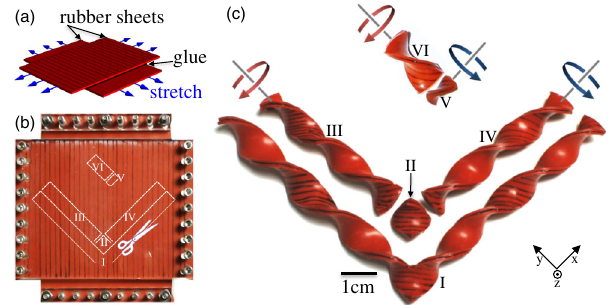
FIG. 1. Orientation-dependent manifestation of handedness in a reflection symmetric continuum. Two identical rubber sheets are uniaxially stretched and glued together to form a rubber bilayer, as done in Ref. [27]. Narrow strips cut from the bilayer curve out of plane to accommodate the difference in rest length between the layers and form helical structures. The square boundaries in II of panel (b) give rise to a cutout [II of panel (c)], which is symmetric under reflections. This is a manifestation of the symmetry of the bilayer’s intrinsic structure. symmetry, e.g., III and IVof panel (b), strips with a well-defined handedness observed depends solely on the orientation of the strip’s long axis; strips aligned with one diagonal generate right- handed helicoids, whereas strips oriented in the perpendicular direction generate left-handed helicoids. Slicing a narrow piece from a left-handed strip such that its aspect ratio is inverted yields a narrower strip of opposite handedness, as seen in V of panel (c), which was cut from VI. The square cutout II in panel (c) holds the capacity to generate both right- and left- handed strips. We thus consider it as possessing both right and left handedness in equal amounts rather than having no handed- ness. It is right handed along the x direction and left handed along the y direction. This directional dependence of the handedness is also observed in the relative positioning of cutouts II, III, and IVof panel (c), where the symmetric cutout II can be seamlessly continued into manifestly right- or left-handed heli- cal structures. Such an orientation-dependent handedness cannot be captured by any pseudoscalar measure, and it calls for quantification by a